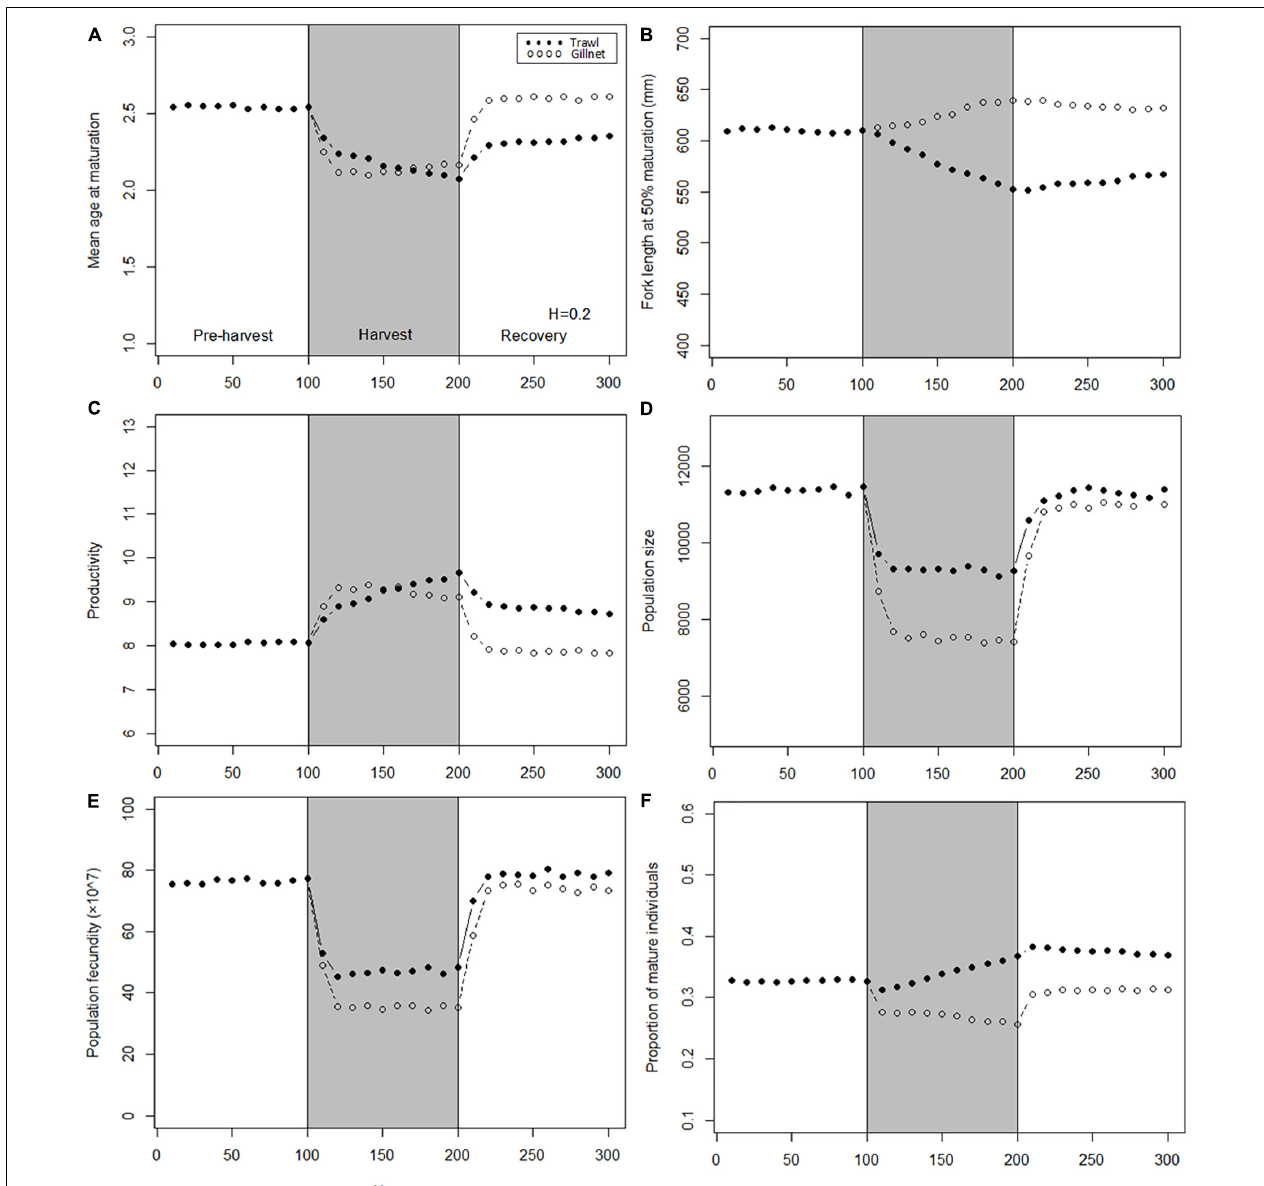
FIGURE 7 | Dynamics of the mean values of population traits before, during and after harvest. Harvest (gray shading) starts at t = 100 years and stop at t = 200 years. Dynamics are shown for two harvest patterns: H = 0.2 year - 1 for trawl (solid points) and H = 0.8 year - 1 for gillnet (hollow points). (A) Mean age at maturation; (B) Fork length at 50% maturation; (C) Population growth rate; (D) Population size; (E) Population fecundity; (F) Proportion of mature